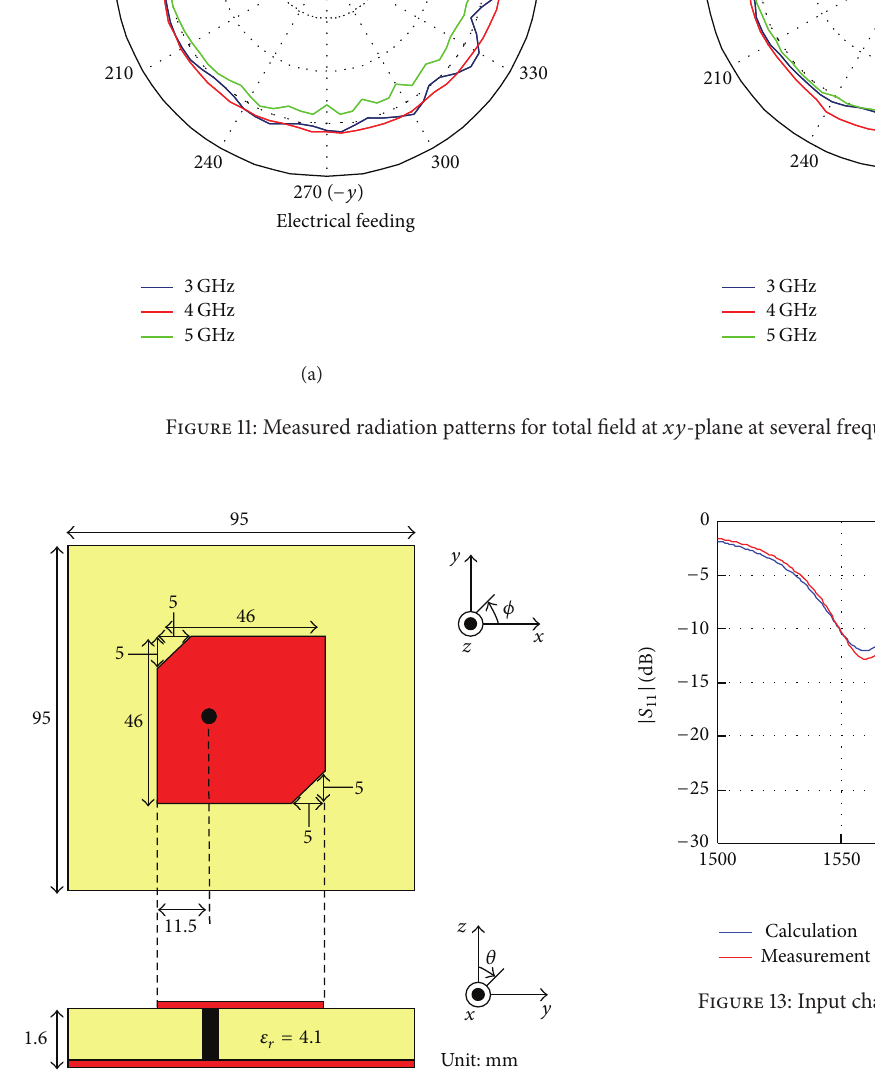
Figure 12: Geometry of CP patch antenna.